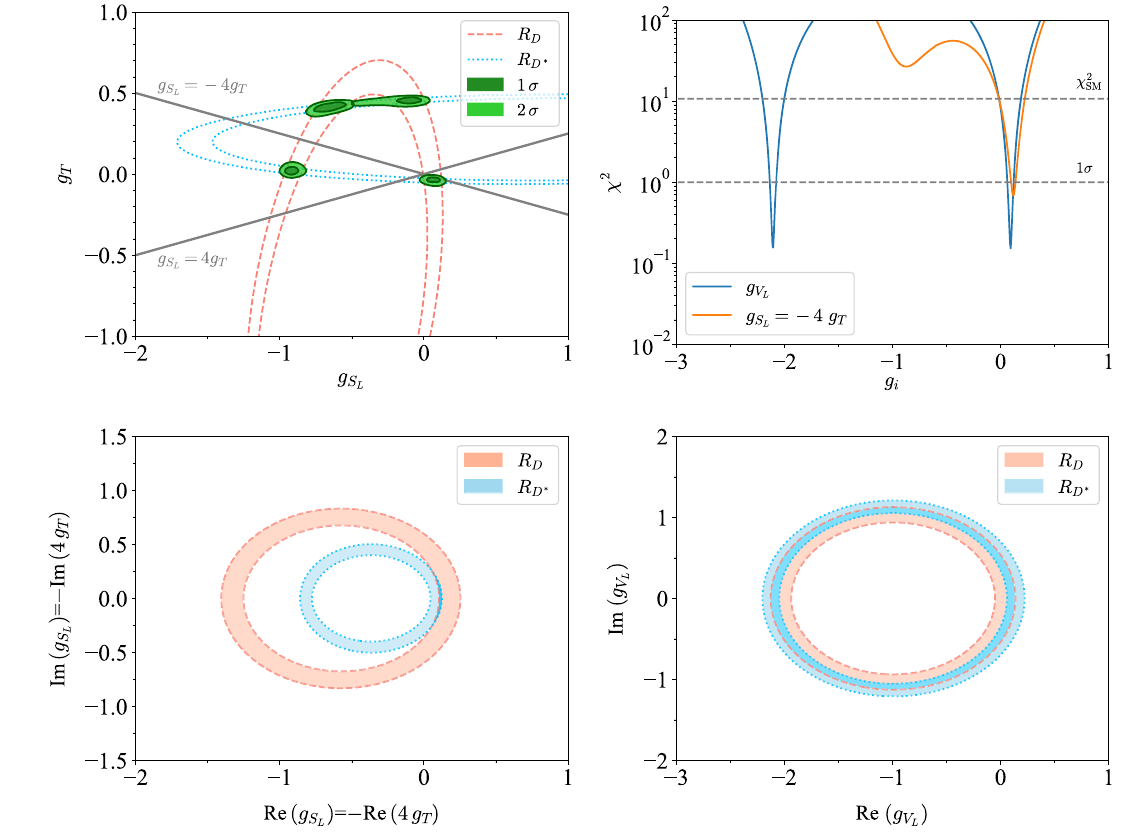
Fig. 3 Upper left: Contour plot of the fit for R D and R D ∗ in the plane respectively. Bottom: Two plots correspond to the complex planes of = − 4 g g S of g S versus g T at the scale μ = 1TeV. The dashed orange and dotted T and g V L , respectively. The orange and blue regions rep- L L blue contours represent the 1 σ allowed regions that explain R D and resent the 1 σ allowed region of R D and R D ∗ , respectively. The deeper R D ∗ , respectively. The dark (light) green region corresponds to the 1 σ blue region corresponds to the overlap scenario where accommodates combined explanation for R D and R D (2 σ )allowedregionthatexplainsbothsimultaneously.Upperright:The χ 2 values to fit both R = − 4 g D and R D ∗ when using g V L and g S L T